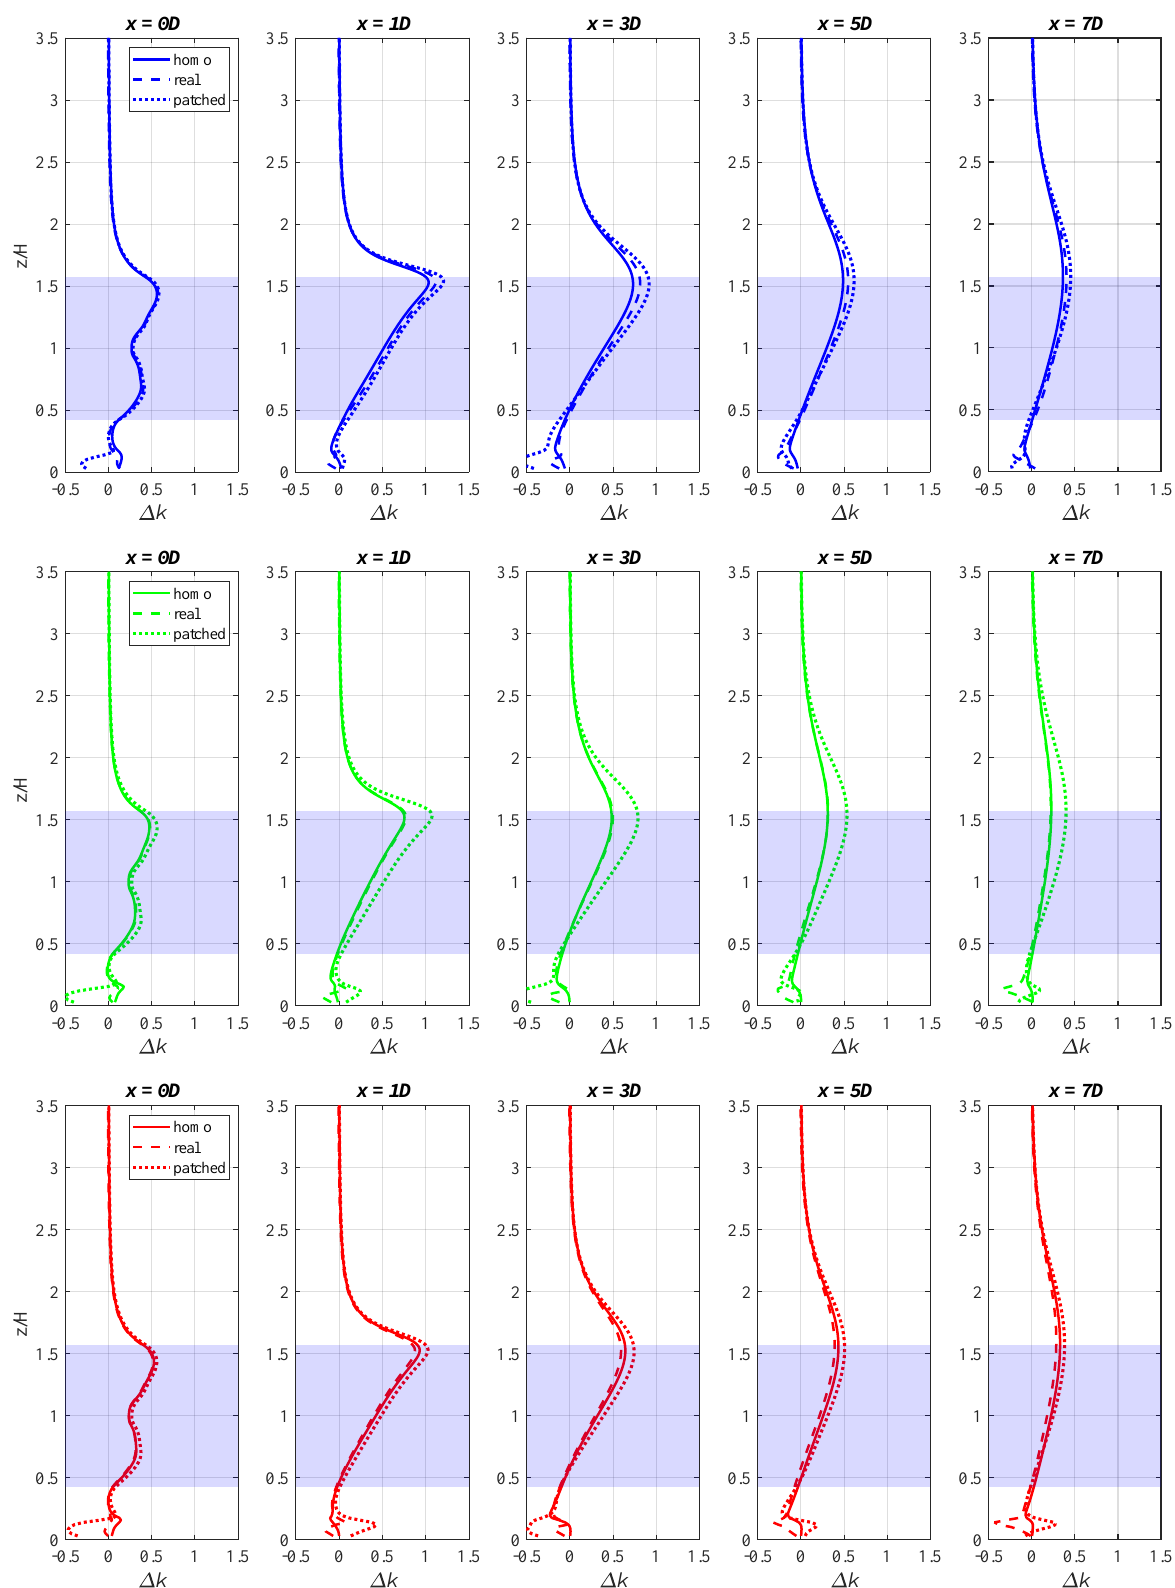
Figure 21. Vertical profiles of TKE deficits ( ∆ k) from the midplane for different densities with varying heterogeneity levels. Blue—LAI ≈ 0.43; green—LAI ≈ 1.7; red—LAI ≈ 4.3. The purple shaded region is the turbine rotor